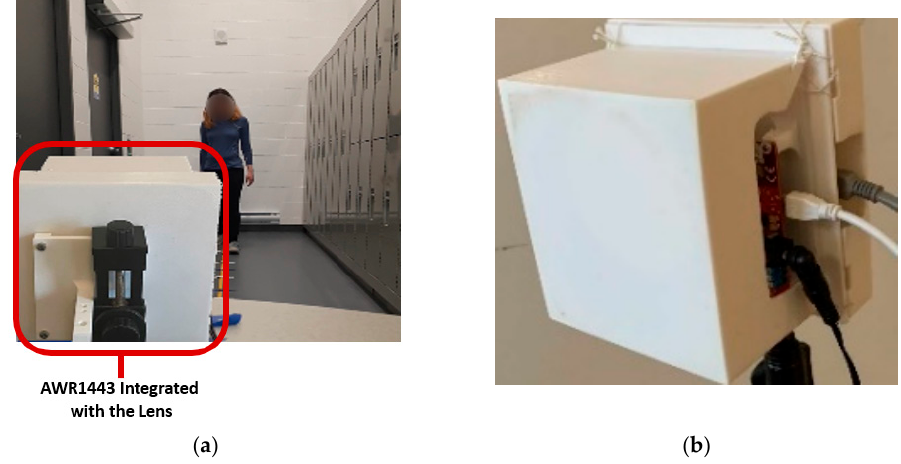
Figure 6. ( a ) experimental setup for hallway gait assessment ( b ) front view of the fabricated system.